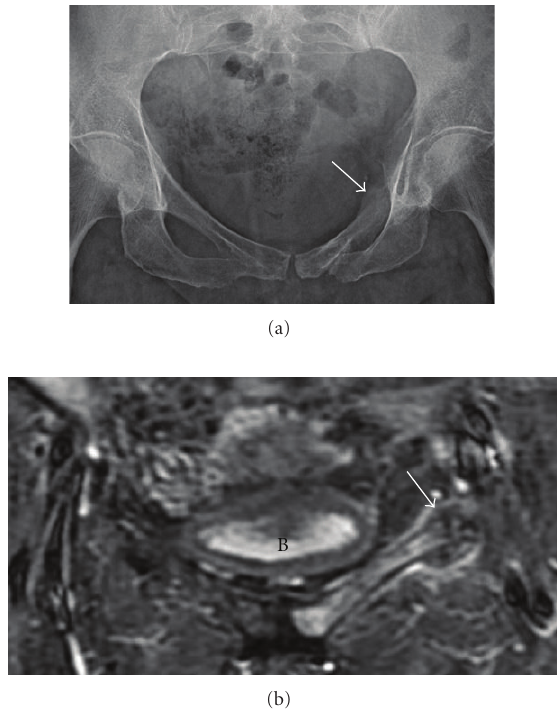
Figure 13: Insu ffi ciency fracture. A 40-year-old male with a pelvic insu ffi ciency fracture. Radiograph (a) demonstrates an expansile osseous lesion with periosteal reaction and maturing callus along the left superior pubic ramus (arrow). No definite fracture line is identified. Coronal STIR (b) of the pelvis demonstrates bone marrow edema throughout the left superior pubic ramus, fracture site, and surrounding callus (arrow). B: bladder.